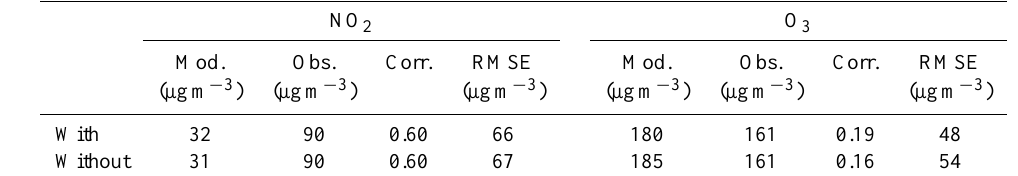
Table 2. As Table 1, but for daily maximum values.